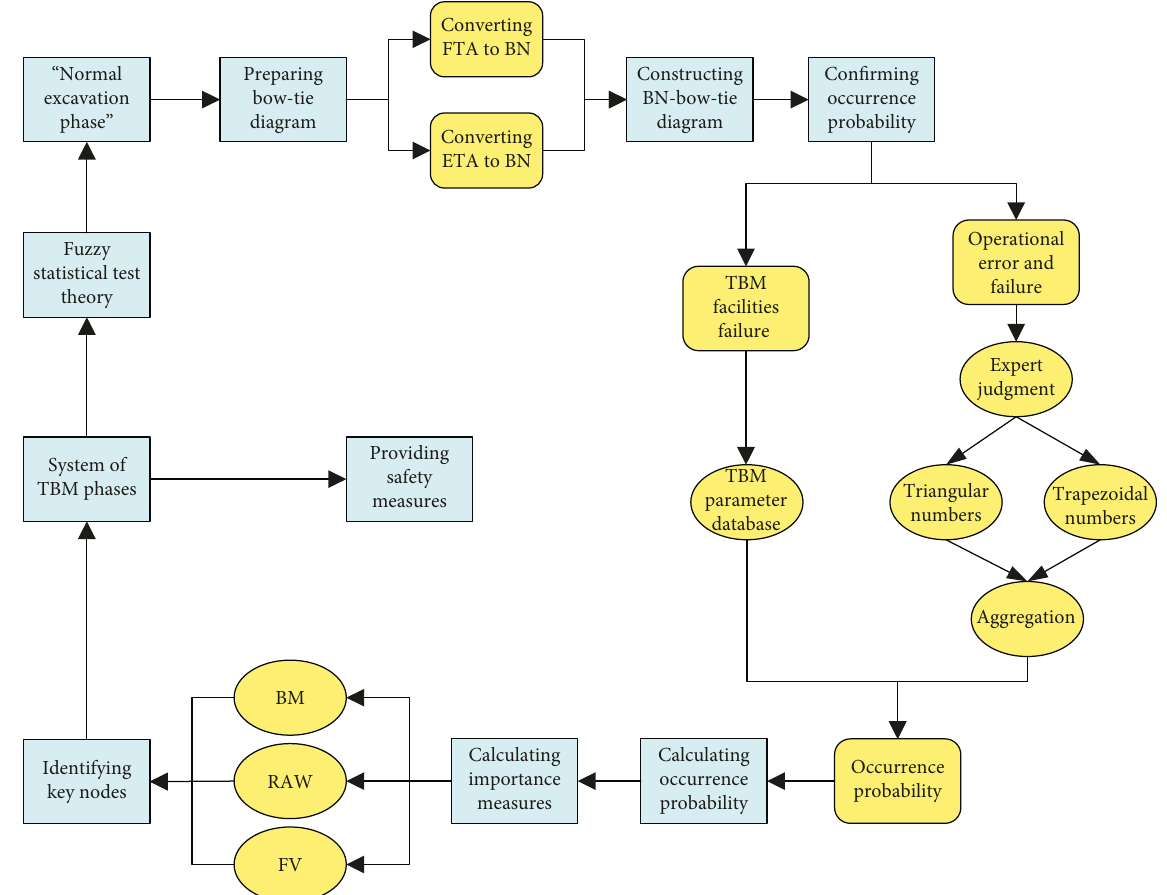
Figure 2: Flowchart of the proposed